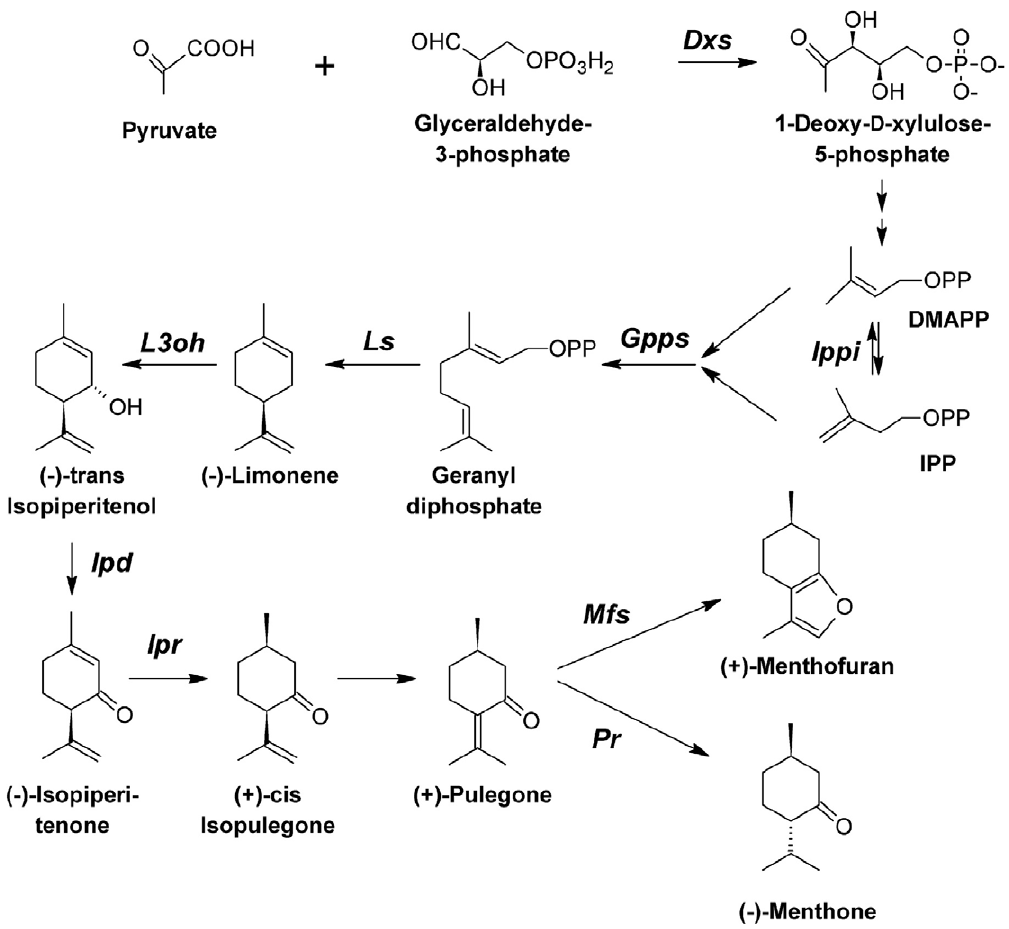
Figure 4. Schematic representation of the monoterpene biochemical pathway in M.aquatica . Dxs , 1-deoxy-D-xylulose-5-phosphate synthase; Gpps indicates geranyl diphosphate synthase; Ls indicates ( 2 )-limonene synthase; L3oh indicates ( 2 )-limonene-3-hydroxylase; Ipd indicates ( 2 )-(3S,4R)- trans -isopiperitenol dehydrogenase; Ipr indicates ( 2 )-isopiperitenone reductase; Mfs indicates ( + )-menthofuran synthase; and Pr indicates ( + )-pulegone reductase.